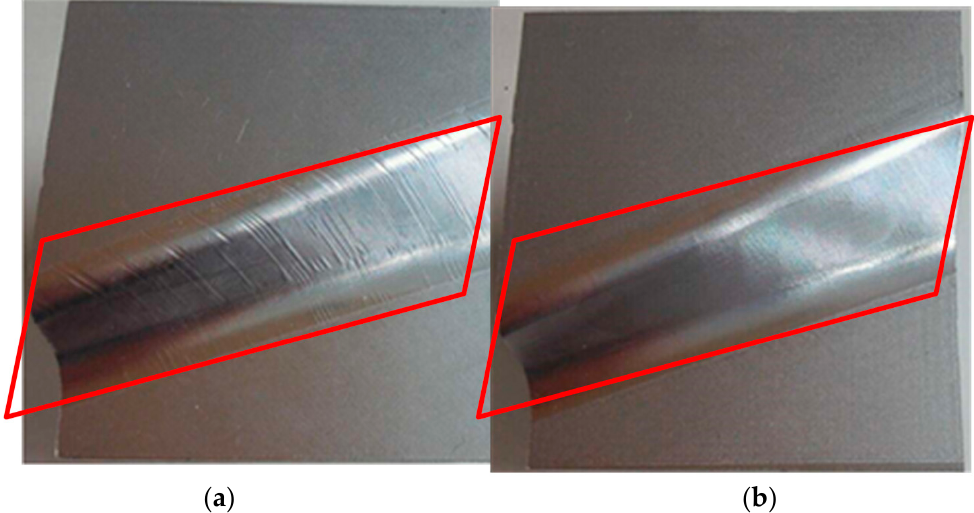
Figure 14. Machining comparison of transition surface with variable curvature ( a ) before optimization ( b ) after optimization. Table 1. Experimental